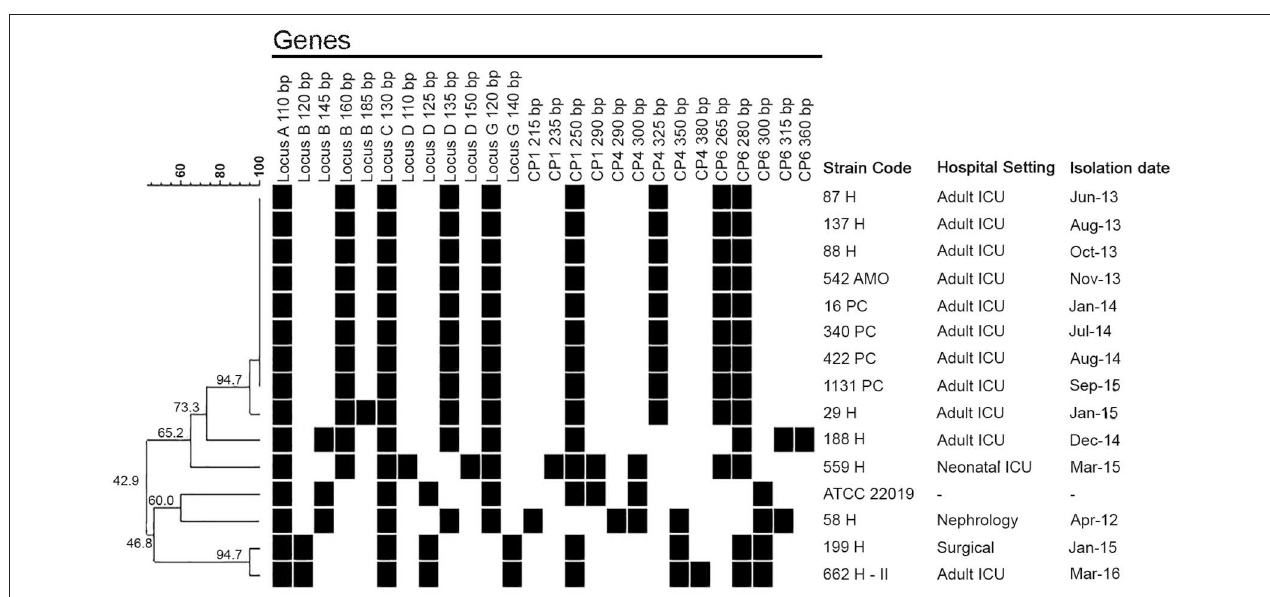
FIGURE 2 | Dendrogram showing the clustering of the 14 Candida parapsilosis ( sensu stricto ) isolates and the ATCC 22019 strain based on microsatellite analysis. The black square indicates the presence of an amplification